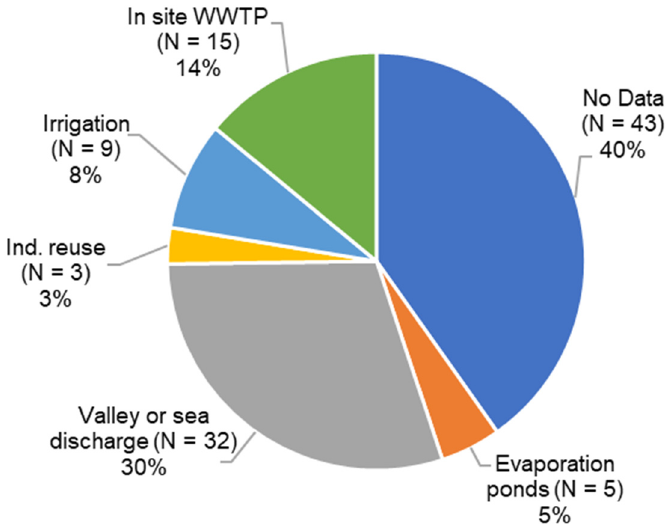
Figure 2. Brine disposal practices in